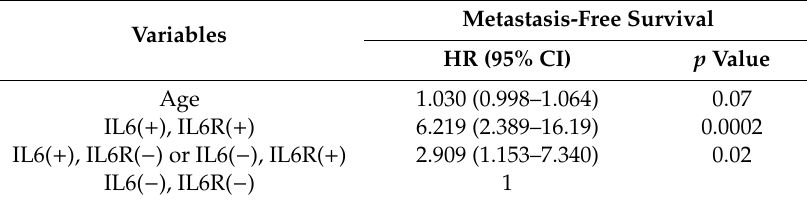
Table 5. Multivariate cox population hazard analysis for metastasis-free